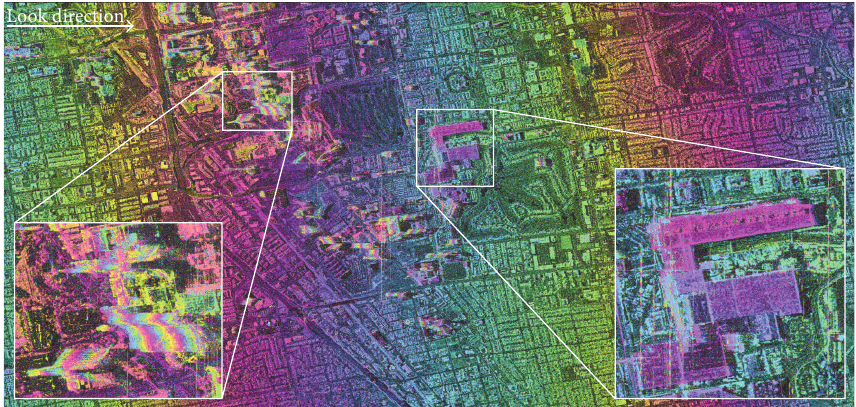
Figure 13: TanDEM-X flattened interferogram in radar coordinates with amplitude image in background. Subsets show hotels and the Las Vegas Convention Center. Temporal baseline 0 days, effective baseline: ∼ 87 m.